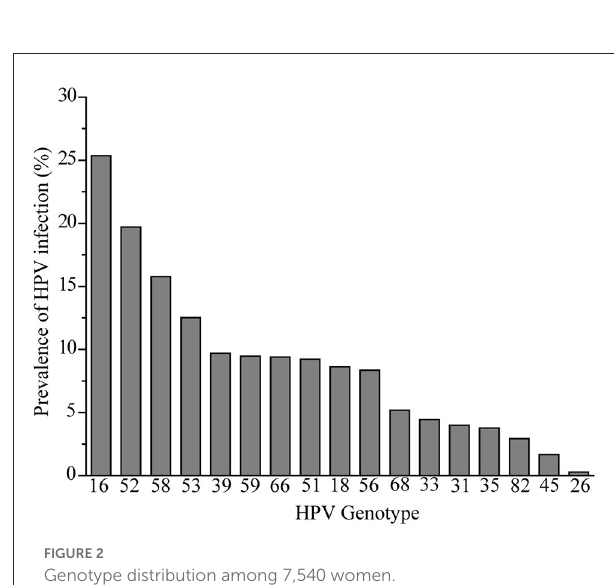
FIGURE2 Genotype distribution among 7,540